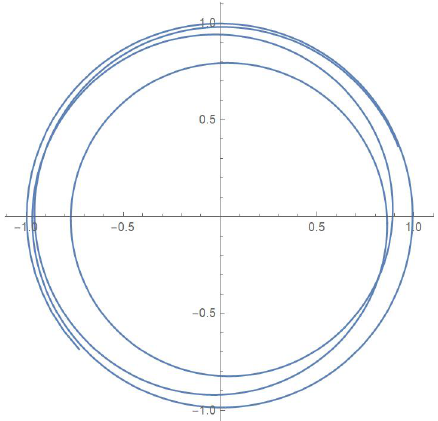
Figure 4 . Unshifted solution for a = arctan 6 and b = 1 arcsin 2 . The string winds around the 5 2 horizon as in the case of a stationary string around a Kerr horizon. However, in this case the horizon is static and the string itself rotates uniformly and therefore has infinite mass and is rather unphysical. The string keeps winding around and has only been plotted partly since Mathematica takes more and more time when getting near the horizon at r/l = 1